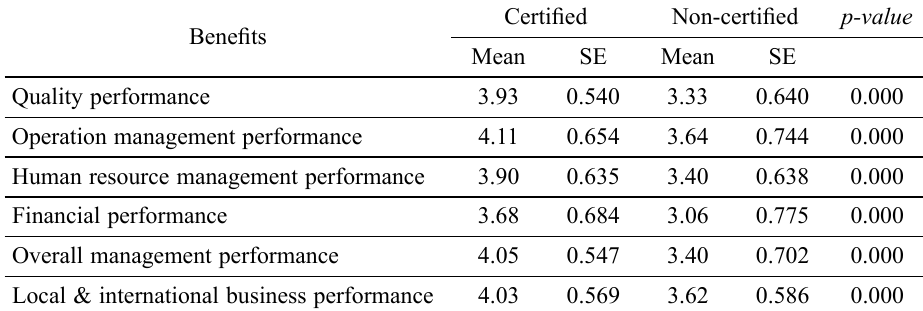
Table 4. Benefits of ISO 9001 certified and non-certified